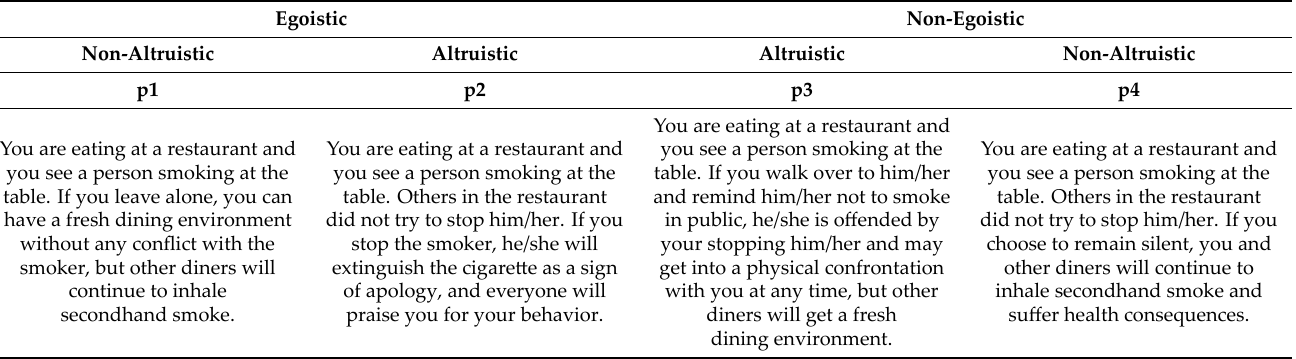
Table 1. An example scene